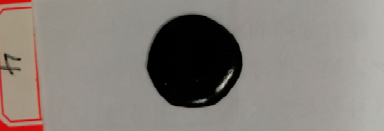
(b) Figure 6. Spectra of asphalt binder, filler, and mastic. ( a ) Base mastic; ( b ) SBS-modified mastic.